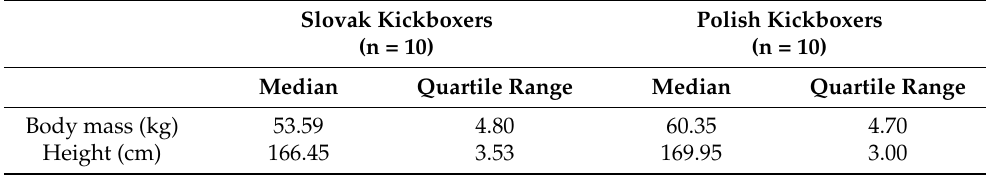
Table 1. Anthropometric